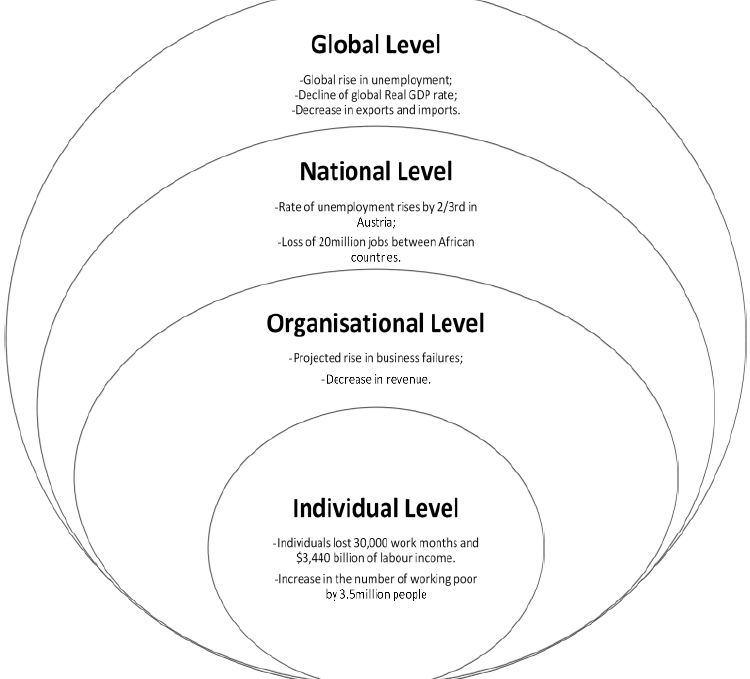
Figure 1: The Socio-Ecological Model (SEM) and the impact of COVID-19 at each social level; Source: Author’s idea drawing from McLeroy